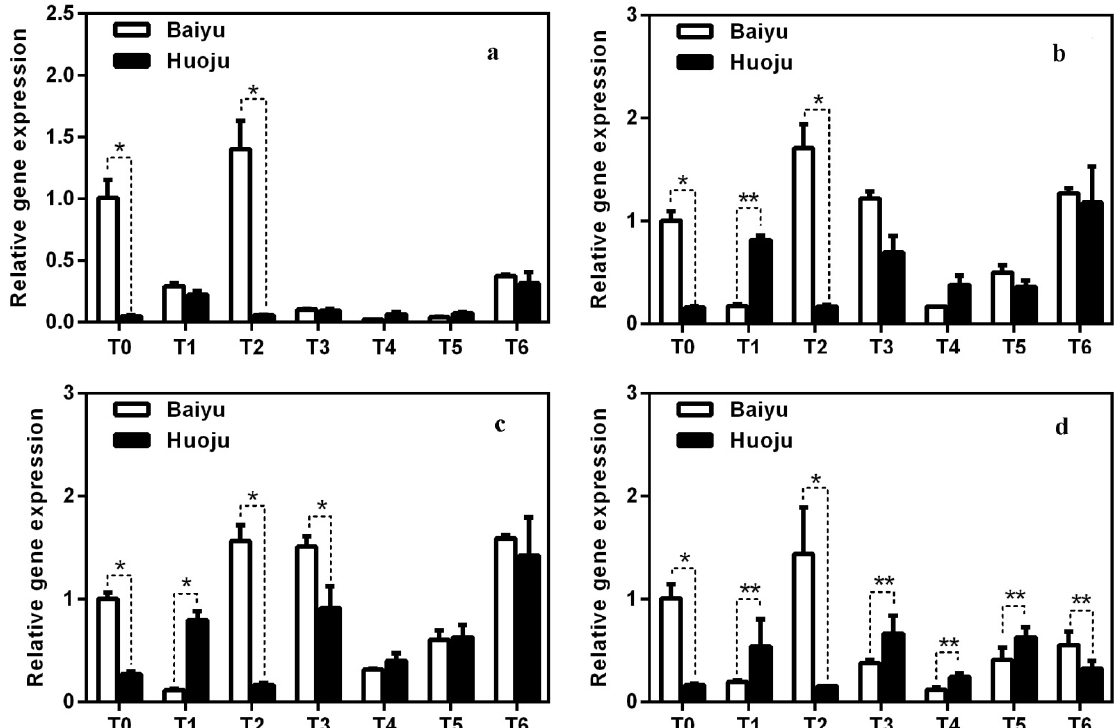
Figure 5. Expression levels of EjFT ( a ), EjFY ( b ), EjFLK ( c ), and EjCAL1-like ( d ) during loquat bud differentiation. Note: T0–T6 in horizontal axis indicates sampling dates, i.e., 7–13, 7–19, 7–27, 8–03, 8–10, 8–17, and 8–24, respectively; * indicates significance at p ≤ 0.05; ** indicates significance at p ≤ 0.01; bars indicate standard error.